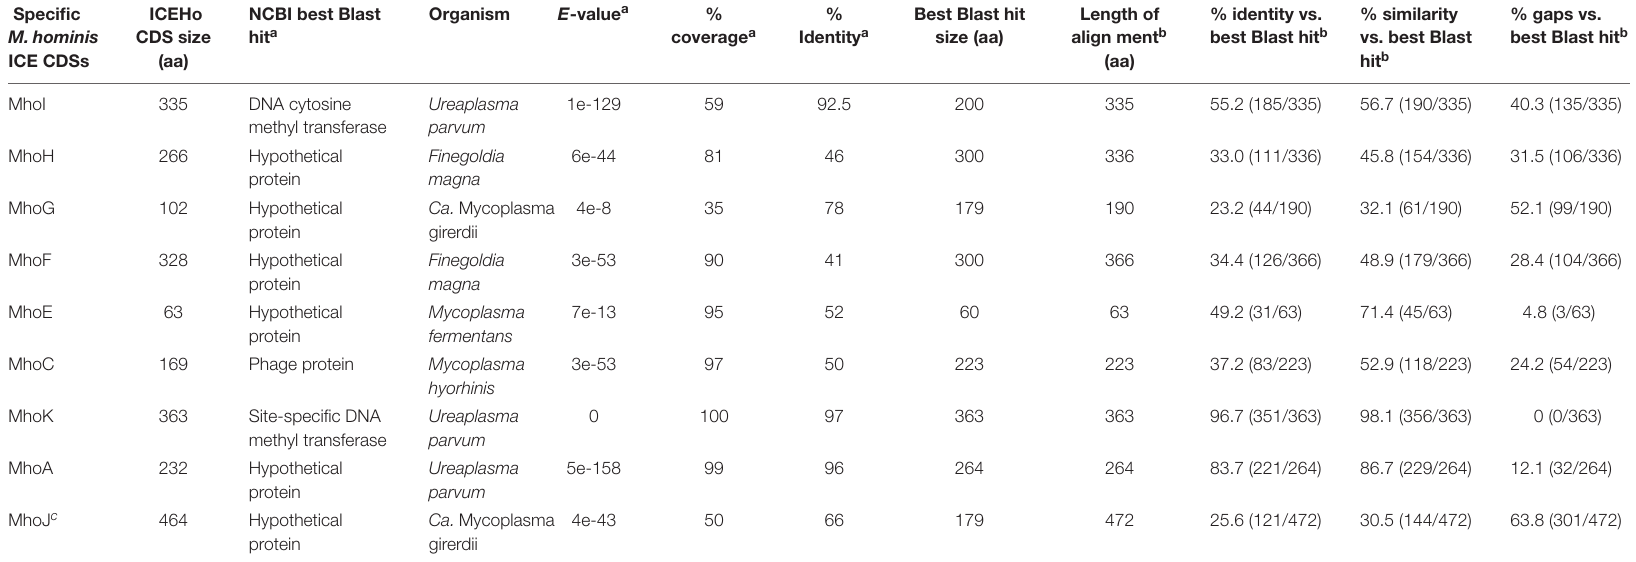
TABLE 4 | Major features of specific M. hominis ICE CDSs. Specific